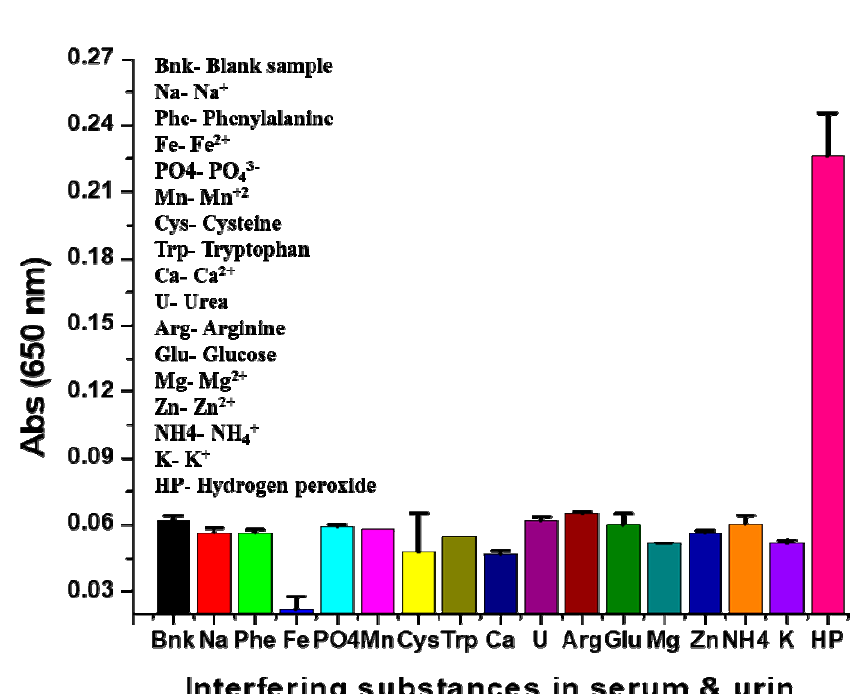
Figure 7. Selectivity of the assay for H 2 O 2 detection: UV / Vis absorbance at 650 nm of various serum-interfering substances and performed triplicate experiments of the selectivity to produce error bars representing the standard deviations.